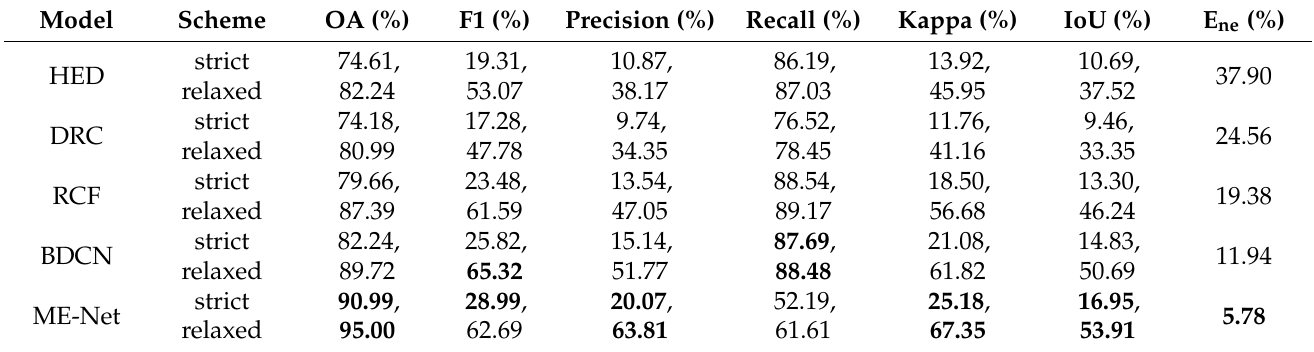
Figure 8. Examples of building edge probability maps produced by five models on the Jiangbei New Area dataset. Columns 1–7 are the images, ground truth labels and prediction results from HED, DRC, RCF, BDCN, and ME-Net, respectively. The even rows are the selected patches of red boxed areas in the odd rows. Table 3. Evaluation results on Massachusetts test set. Each cell has the value with strict and relaxed metrics and the best values are masked as bold for columns 3–8. The last column is E ne , and the lowest value indicates the clearest and crispest